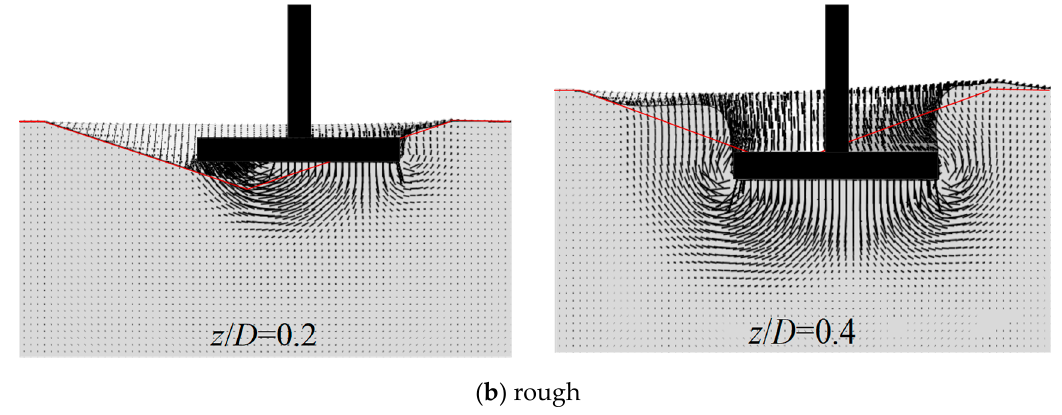
Figure 13. The soil flow mechanism of ( a ) smooth and ( b ) rough conditions. (TB − 2 D − 0.25 D ).